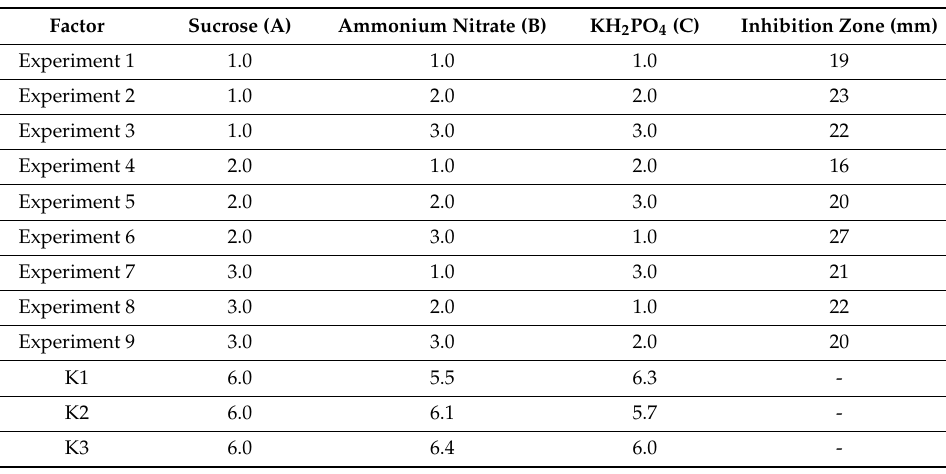
Table 3. Results of the L9 (3 × 3) orthogonal array